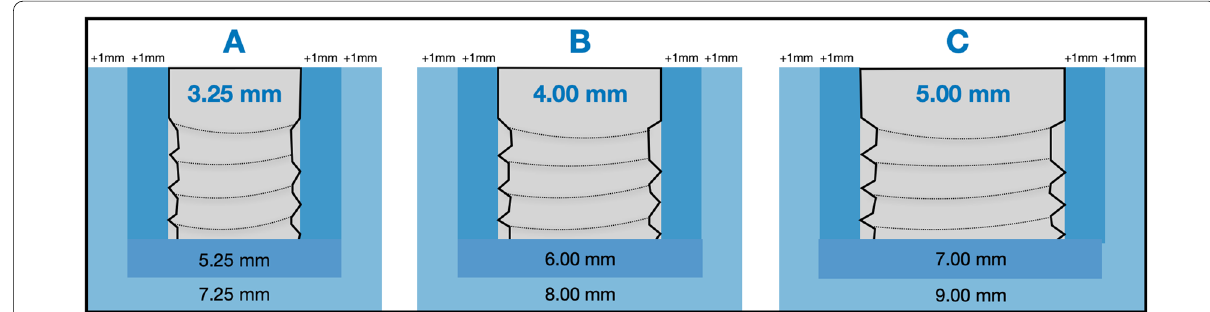
Fig. 1 Illustration of the calculations with regard to a theoretical bony housing with circumferential bone thicknesses of either 1 or 2 mm of three different implant diameters ( A – C ). Probability calculations were the used accordingly